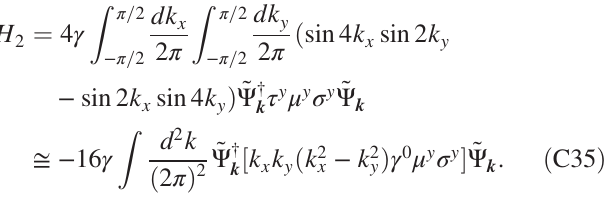
TABLE III. Symmetry action on the bosonic spinon and Higgs fields in the bosonic dual to the theories studied here, as presented in Eqs. (1.4) and (1.7) [22]. The spinon here is written as a two component spinor, z ¼ ð z ↑ ; z ↓ Þ T , with i σ y acting on the ↑ , ↓ indices. We note that T ½ z (cid:2) (cid:4) ¼ − i σ y z (cid:2) and that T